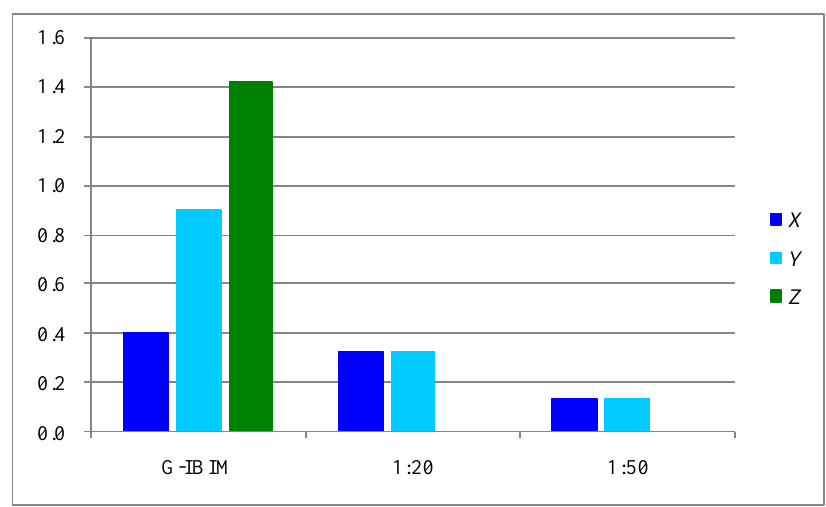
Figure 9. Normalized